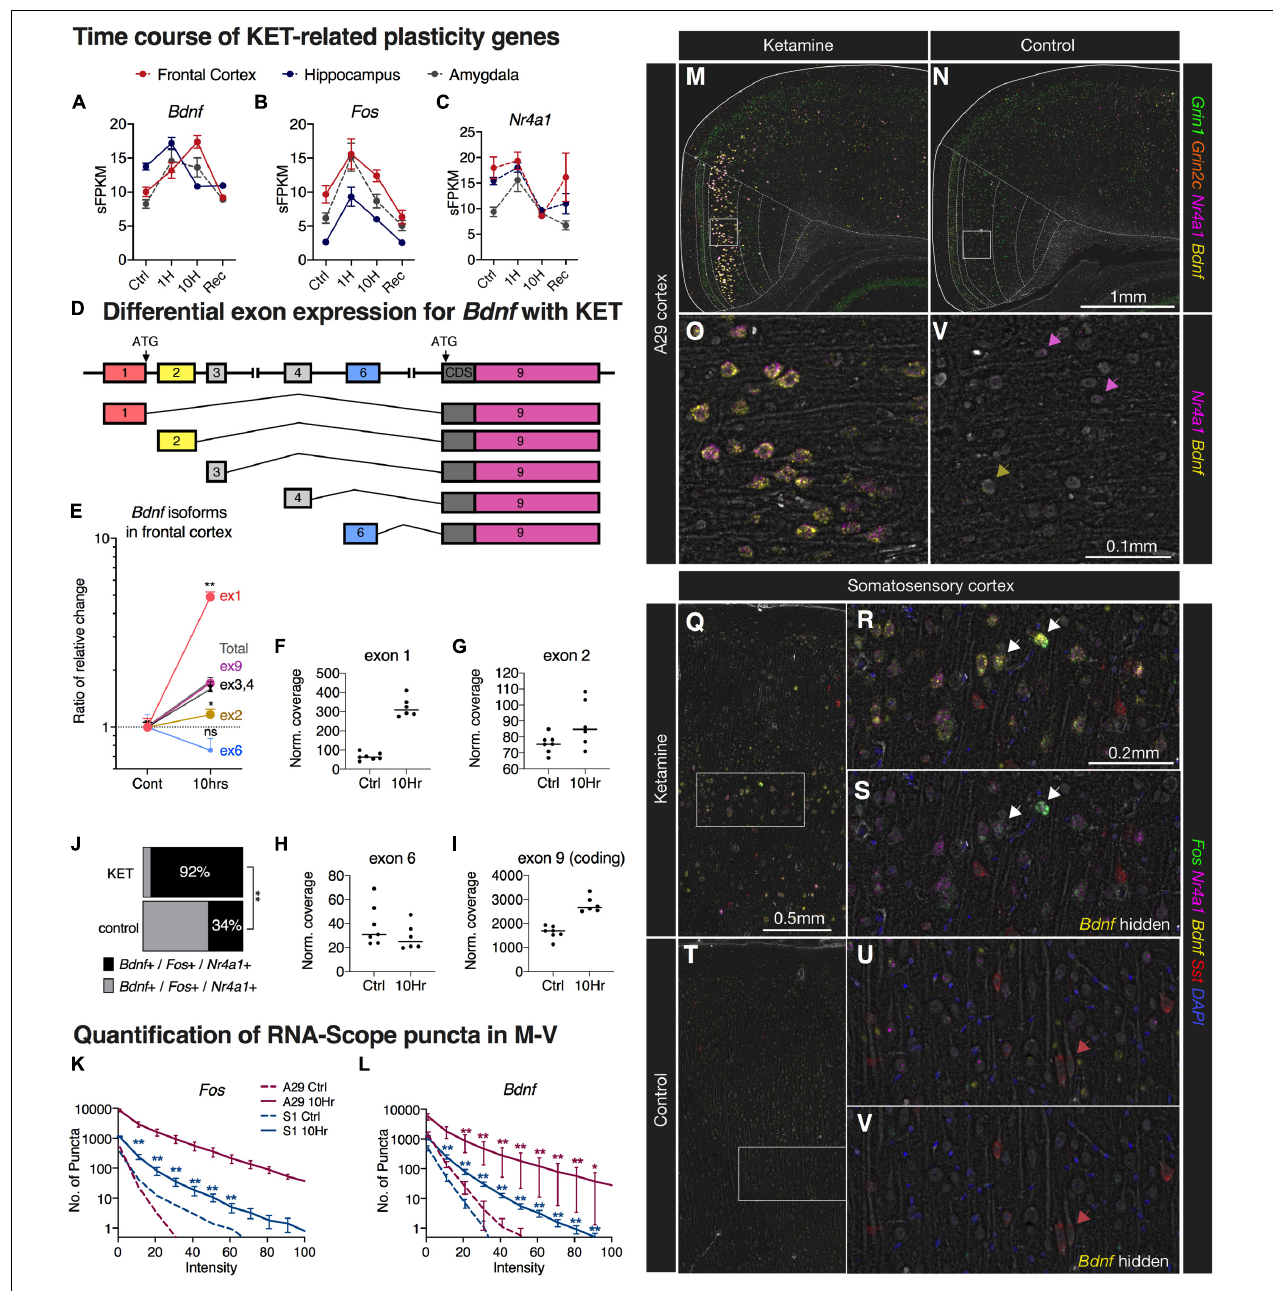
FIGURE 6 | Multiplex fluorescent in situ hybridization, quantification, and splice analysis of selected ketamine-induced cortical neuroplasticity genes. (A–C) Expression level of Fos , Bdnf , and Nr4a1 were measured, each showing differing patterns of expression over time. Transcripts for Bdnf showed notably different expression patterns between brain regions, while the other two genes showed consistent effects in these three brain regions. (D) The Bdnf gene contains several exons, which all splice to the coding exon 9. ( E–I) Exon-level expression was assessed using JunctionSeq showing a significant increase in exon 1 variants relative to the total, whereas exon 2 was not induced by ketamine. (J–V) Using in situ hybridization, we investigated the effects of ketamine on specific transcripts. (J) After ketamine, significantly more Bdnf + / Fos + cells also contained Nr4a1 + puncta. (K,L) Induction of both Fos and Bdnf transcripts was observed in cortical pyramidal neurons after 10 h of ketamine administration, with larger magnitudes of effect size observed in A29 cortex. This was manifested as an increase in intensity of the staining. (M,N) A representative image is shown for A29 retrosplenial cortex, with a medial induction pattern. (O,P) In the magnified images, strong staining is noted in large pyramidal cells with weaker staining and less co-expression observed in controls (colored arrows). (Q–S) A similar effect was observed in deeper layers of somatosensory cortex, although less pronounced. (T–V) Control somatosensory cortex showed faint staining for Fos / Nr4a1 / Bdnf , while somatostatin staining (red arrows) remained relatively constant. (M–V) Brightness was enhanced for visibility at low power for this display. Statistical tests used: (E) JunctionSeq statistics; (J) Chi-square analysis; (K,L) Repeated measures two-way ANOVA on log-transformed values; *, p < 0.05; **, p < 0.01. For all panels, error bars represent the standard error of the mean. Brightness in these images was enhanced for visibility at low